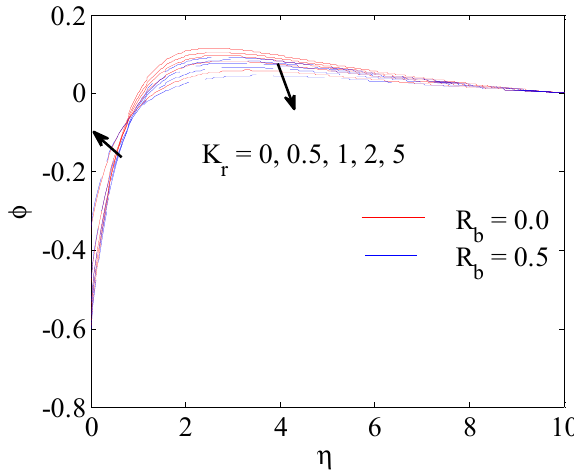
Figure 11. Fluctuations of ϕ due to the factor W (cid:2915) .